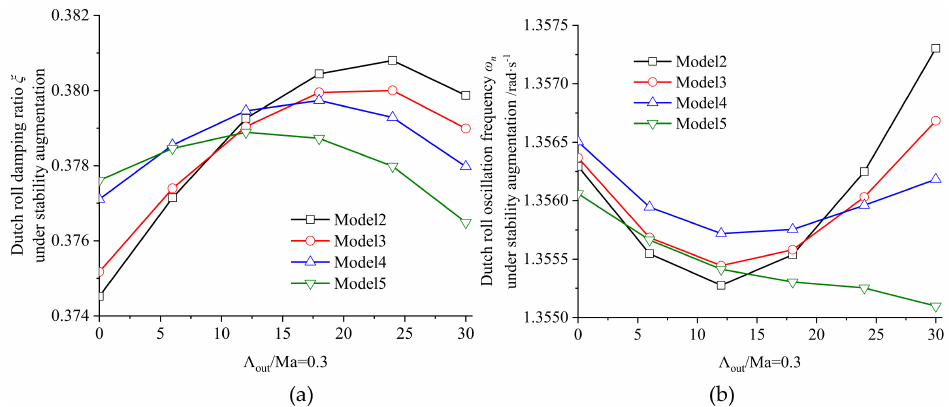
Figure 15. The damping ratio ξ and the oscillation frequency ω n of the Dutch roll modal of the pre-selected model after the stability augmentation adjustment with Λ out corresponding to the configurations when Ma = 0.3. ( a ) Damping ratio ξ , ( b ) oscillation frequency ω n .